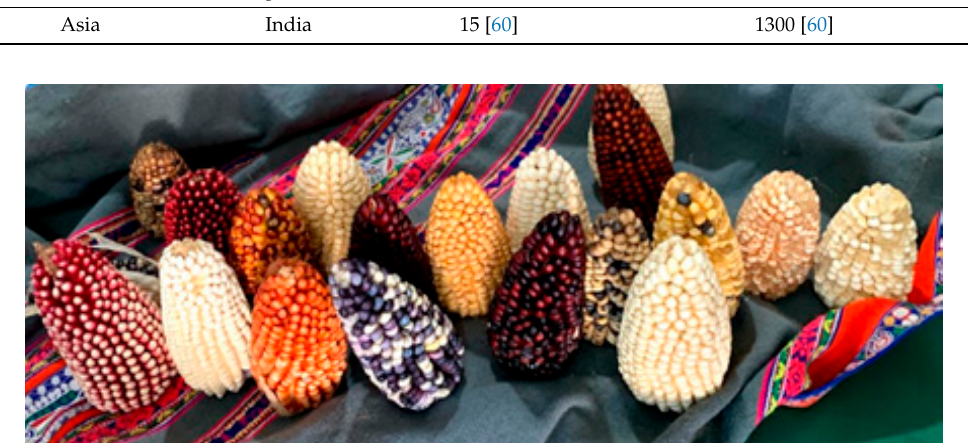
Figure 1. Phenotypic variability of some corn landraces from Southern Andean region of Peru (from author's personal file ).